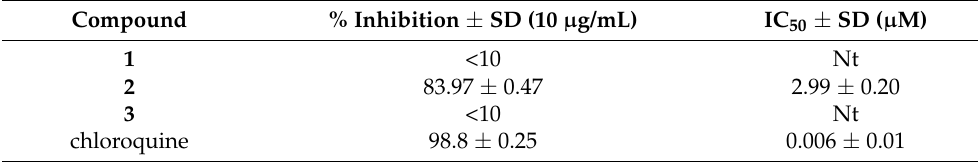
Table 5. Antiplasmodial activity against the chloroquine-sensitive P. falciparum strain